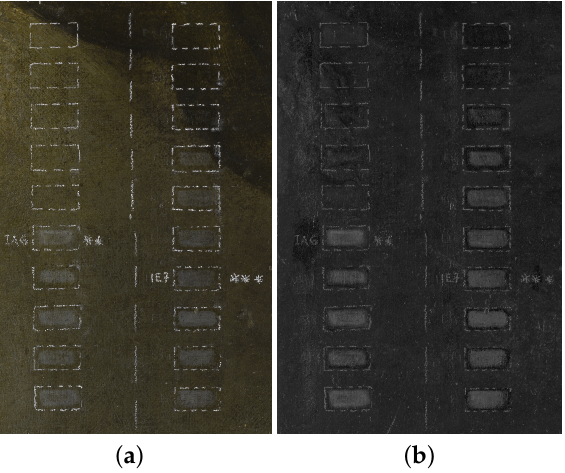
Figure 9. Technical photography: ( a ) VIS. ( b ) UV reflected. The ROIs were treated with solvent mixtures isooctane-acetone (left column) and isooctane-ethanol (right column), with the concentration of acetone and of ethanol increased at a step of 10% (top to bottom). ROIs labeled with stars represent two particular mixtures chosen by the restorer.